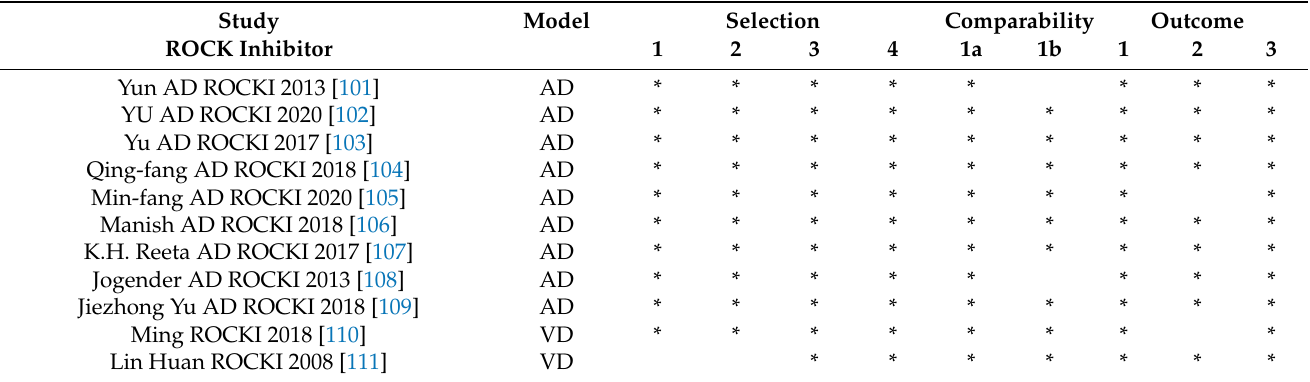
Table 1. Newcastle-Ottawa quality assessment scale cohort